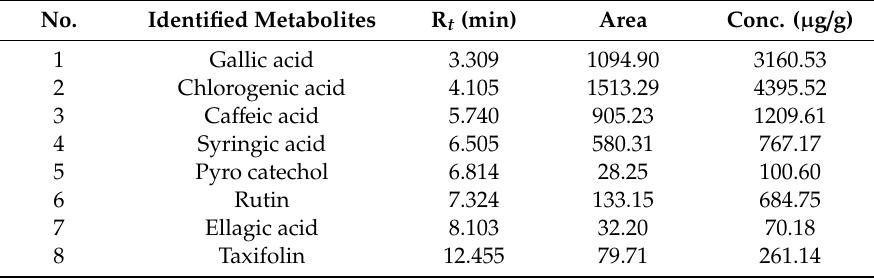
Table 3. Identified compounds of C. vitellina extract using HPLC.